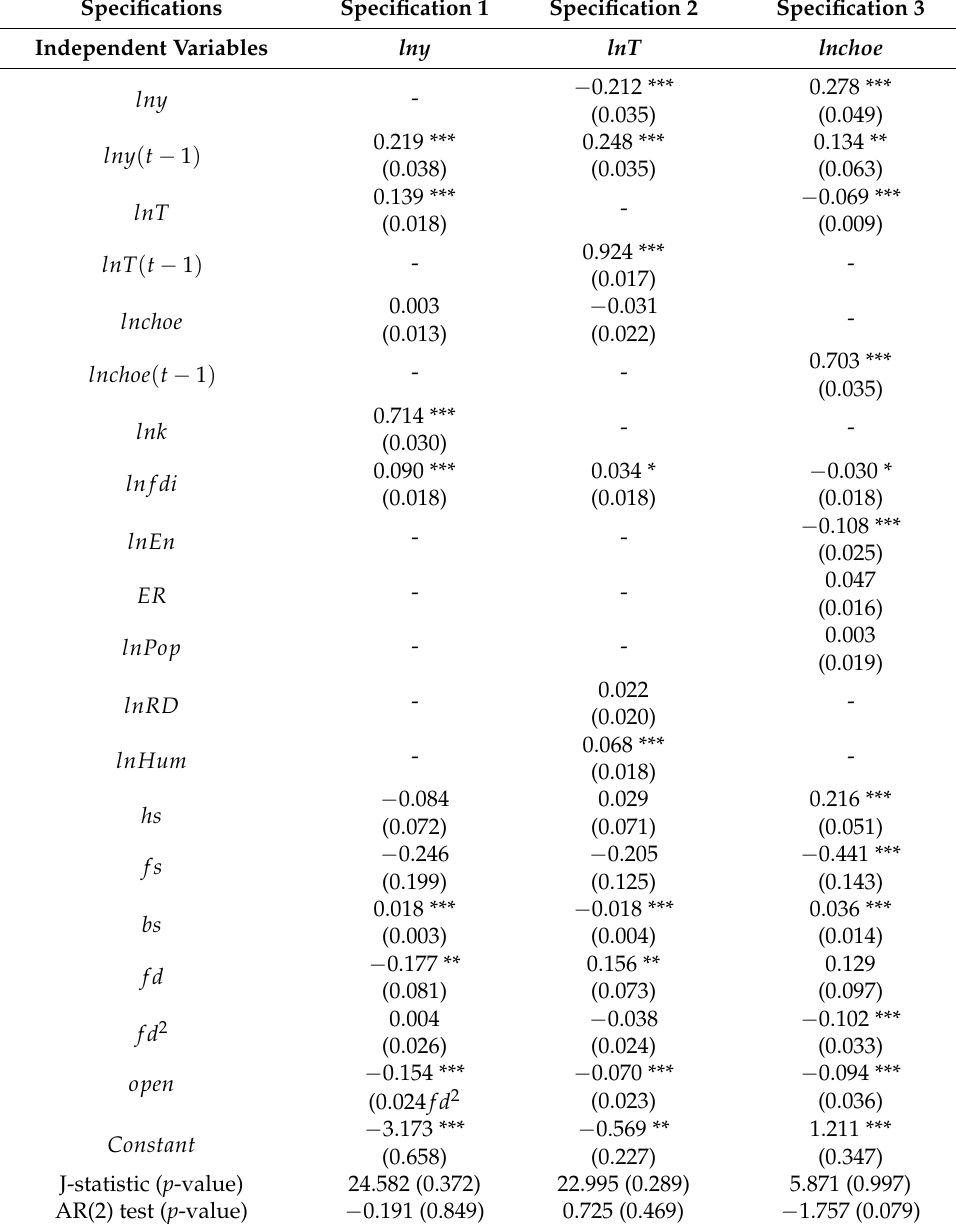
Table 5. GMM estimation results of panel simultaneous equations of Equations (11)–(13) ( R represents choe